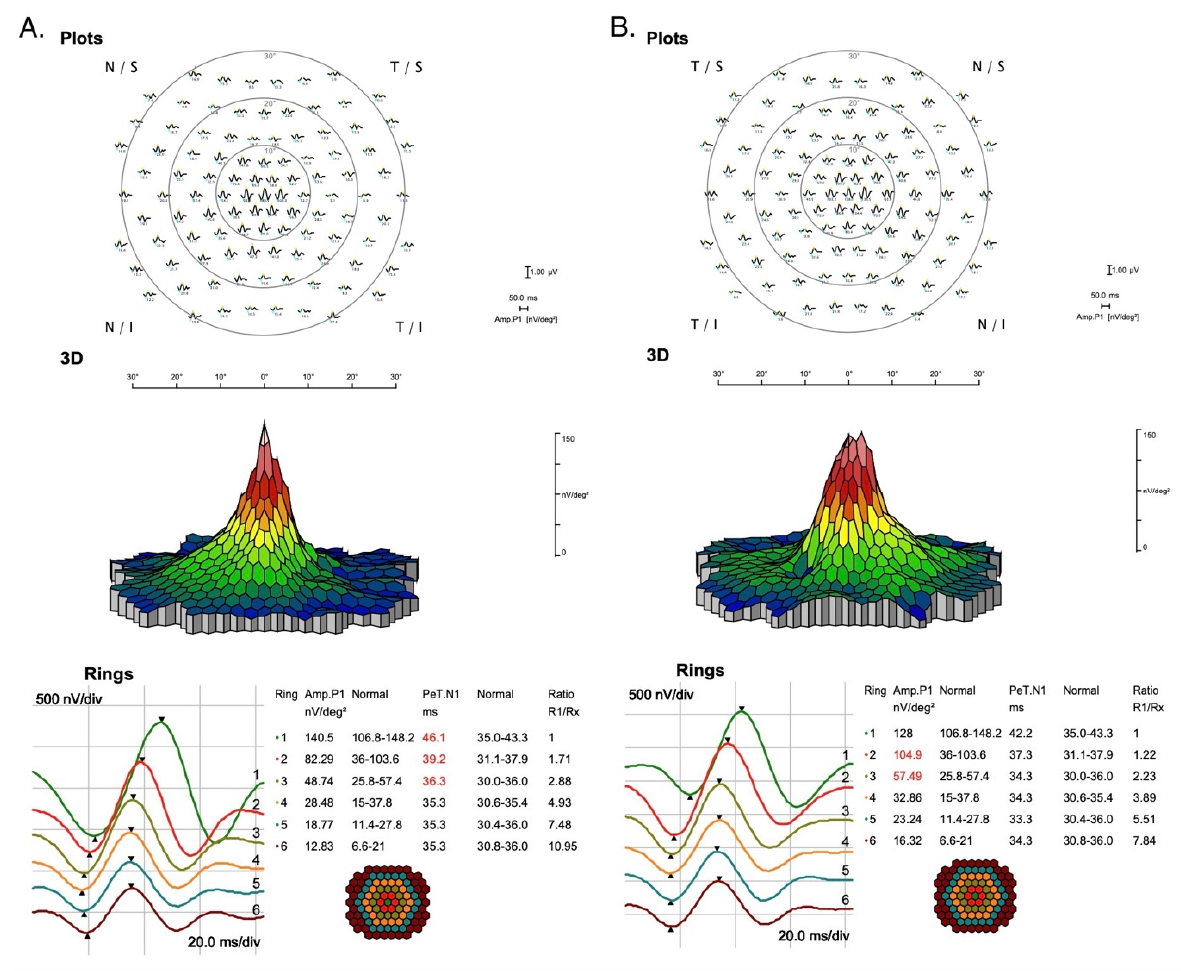
Figure 6. MfERG and impaired functional activity of cones/bipolars in right ( A ) and left eyes ( B